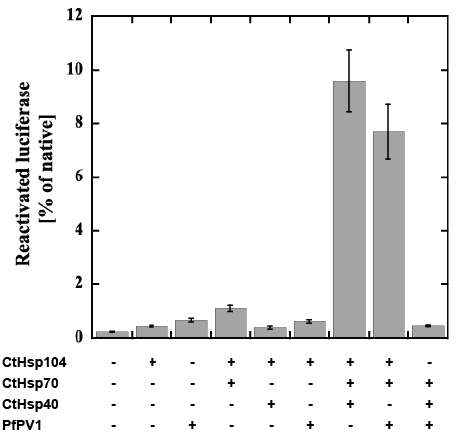
Figure 7. Reactivation of luciferase by the CtHsp104 system and PfPV1. Luciferase was denatured by urea treatment and applied for reactivation with the various combinations of CtHsp104 system components and rPfPV1-Strep. The bioluminescence of reactivated luciferase is expressed as the relative value of untreated luciferase.